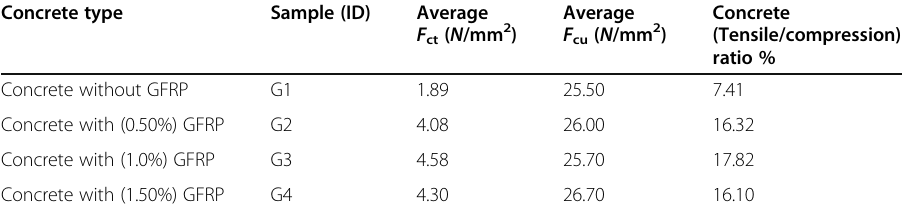
Table 8 The difference between compressive strength and tensile splitting strength due to short glass fiber in